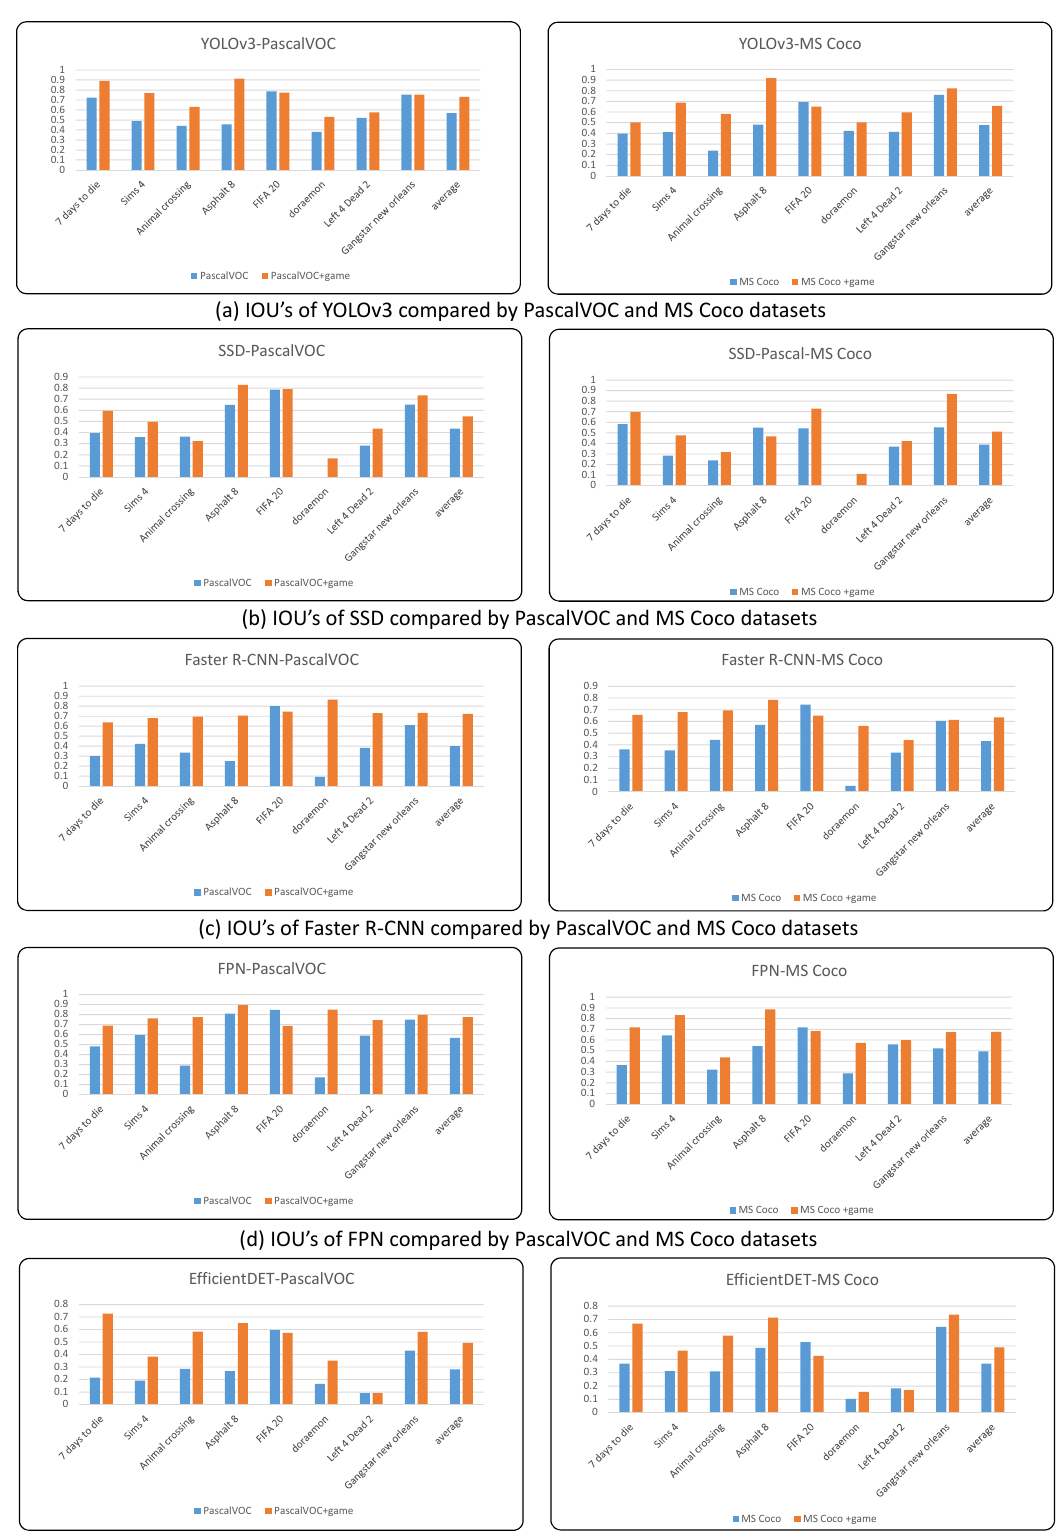
Figure 4. IoUs from five object detection algorithms trained by different datasets are compared. In the left column, blue bars denote IoUs from those models trained using PascalVOC only and red bars are for PascalVOC + game scenes. In the right column, blue bars denote IoUs from those models trained using MS COCO only and red bars are for MS COCO + game